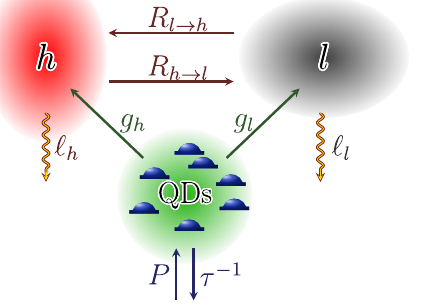
FIG. 1. Illustration of the relevant processes in our bimodal system. The intermode kinetics between the modes h and l is determined by the rates R . The modes lose their photons with i → j rates l . This loss is compensated by new excitation from the i quantum dots (QDs) with gain rates g . The quantum dots are i pumped with rate P , and they lose their excitations spontaneously with rate τ − 1 .